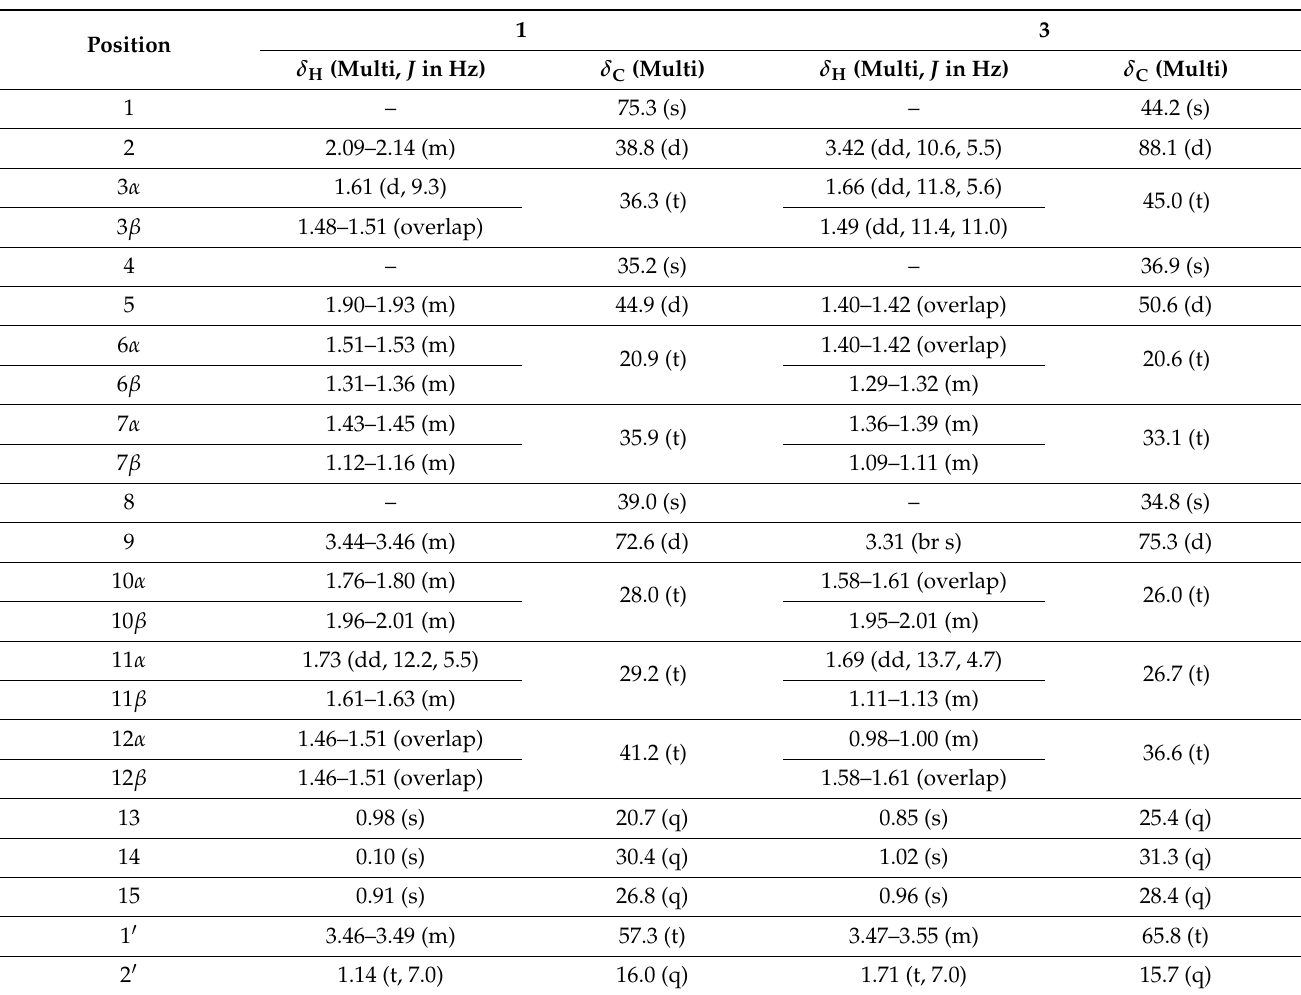
Table 1. 1 H NMR and 13 C NMR spectroscopic data of compounds 1 and 3 in CDCl 3